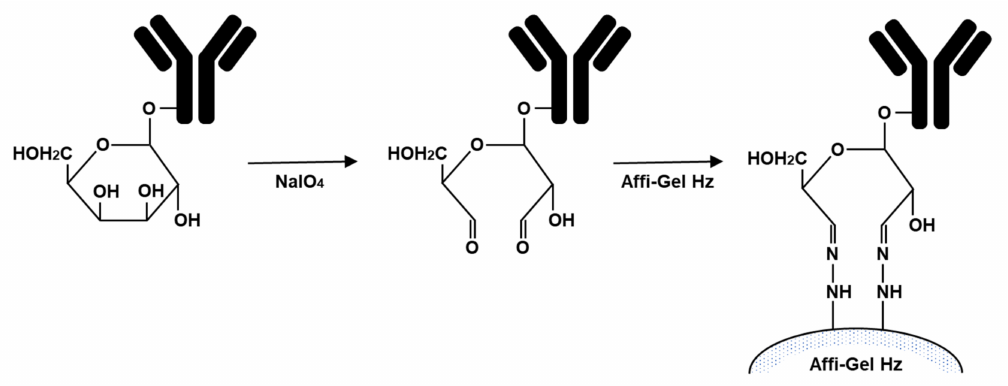
Figure 1. Scheme of the preparation of an immunoaffinity column with MAbs against natural